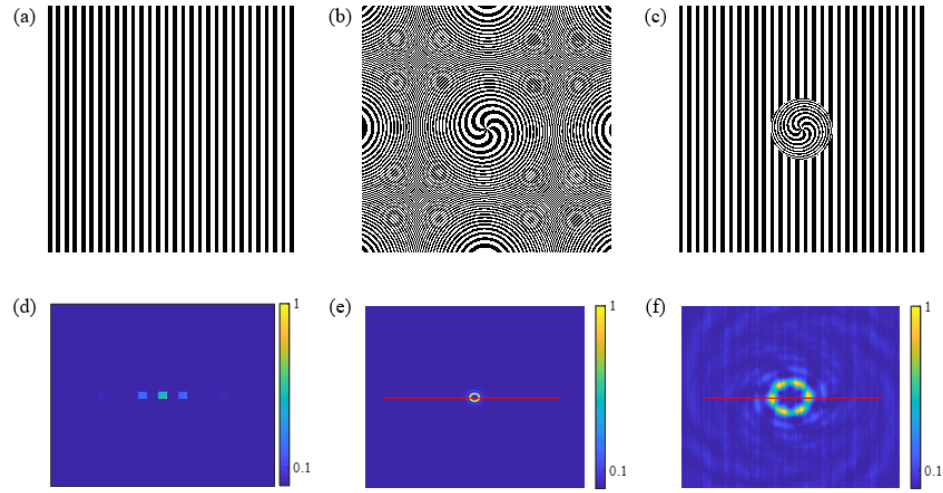
Figure 2. Schematic diagrams of ( a ) the grating, ( b ) the SZP and ( c ) the CSZPG . ( d – f ) show the corresponding simulated normalized diffraction patterns for ( a – c ), respectively.